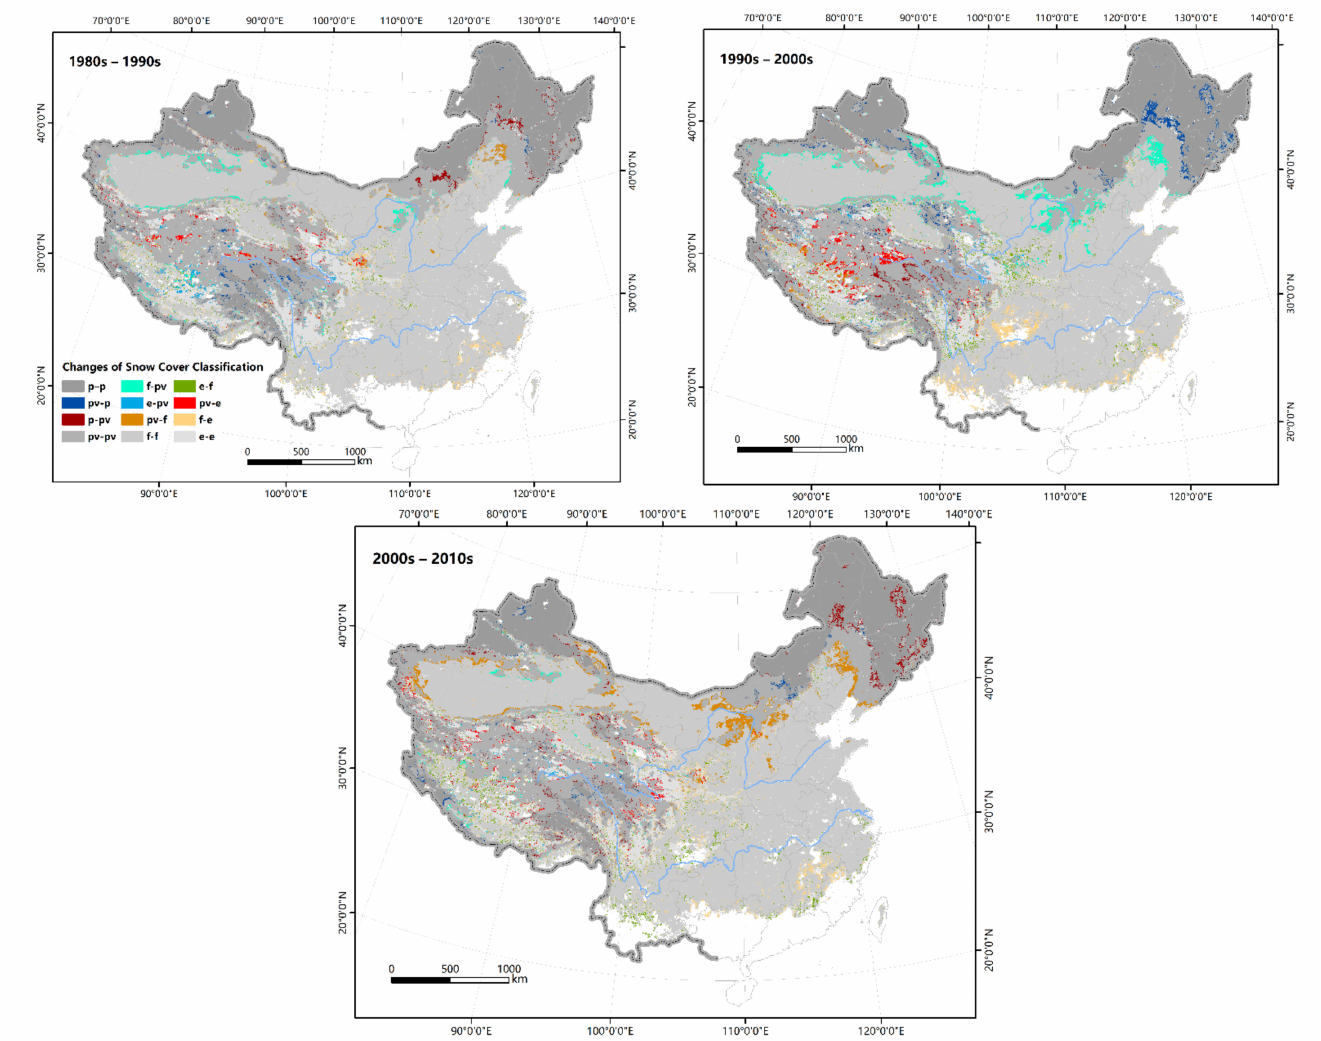
Figure 6. Interdecadal variations in the recently developed snow cover classification across China from the 1980s to the 1990s ( left ), from the 1990s to the 2000s ( right ), and from the 2000s to the 2010s ( bottom ). The colors represent the changes in different types. The alphabet is the first letter of the snow cover